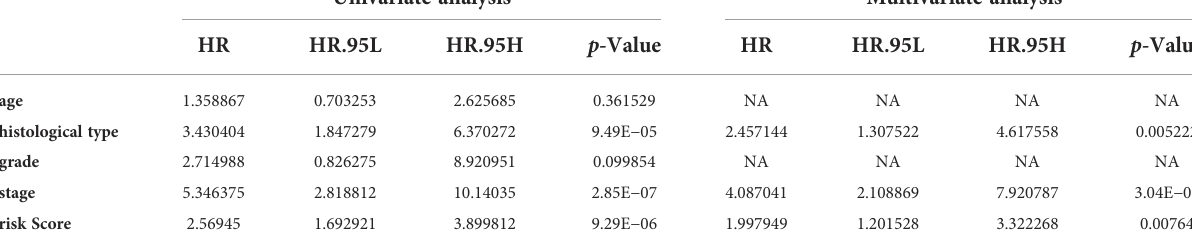
TABLE 2 Independent prognostic analysis of test cohort.